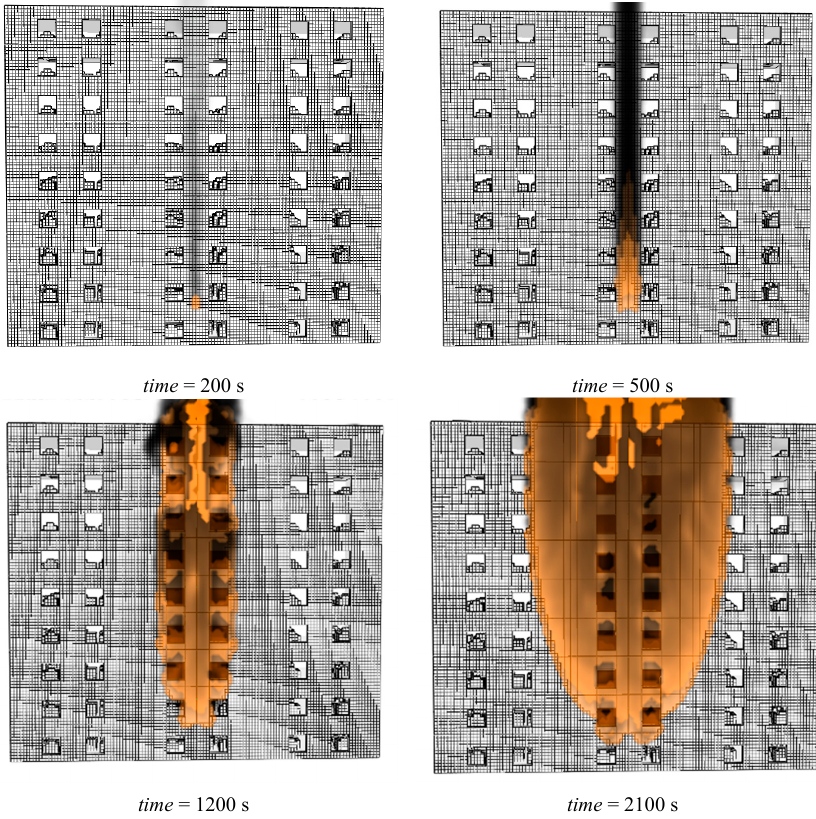
Figure 9. Fire spread upward along the building's exterior predicted by LES.